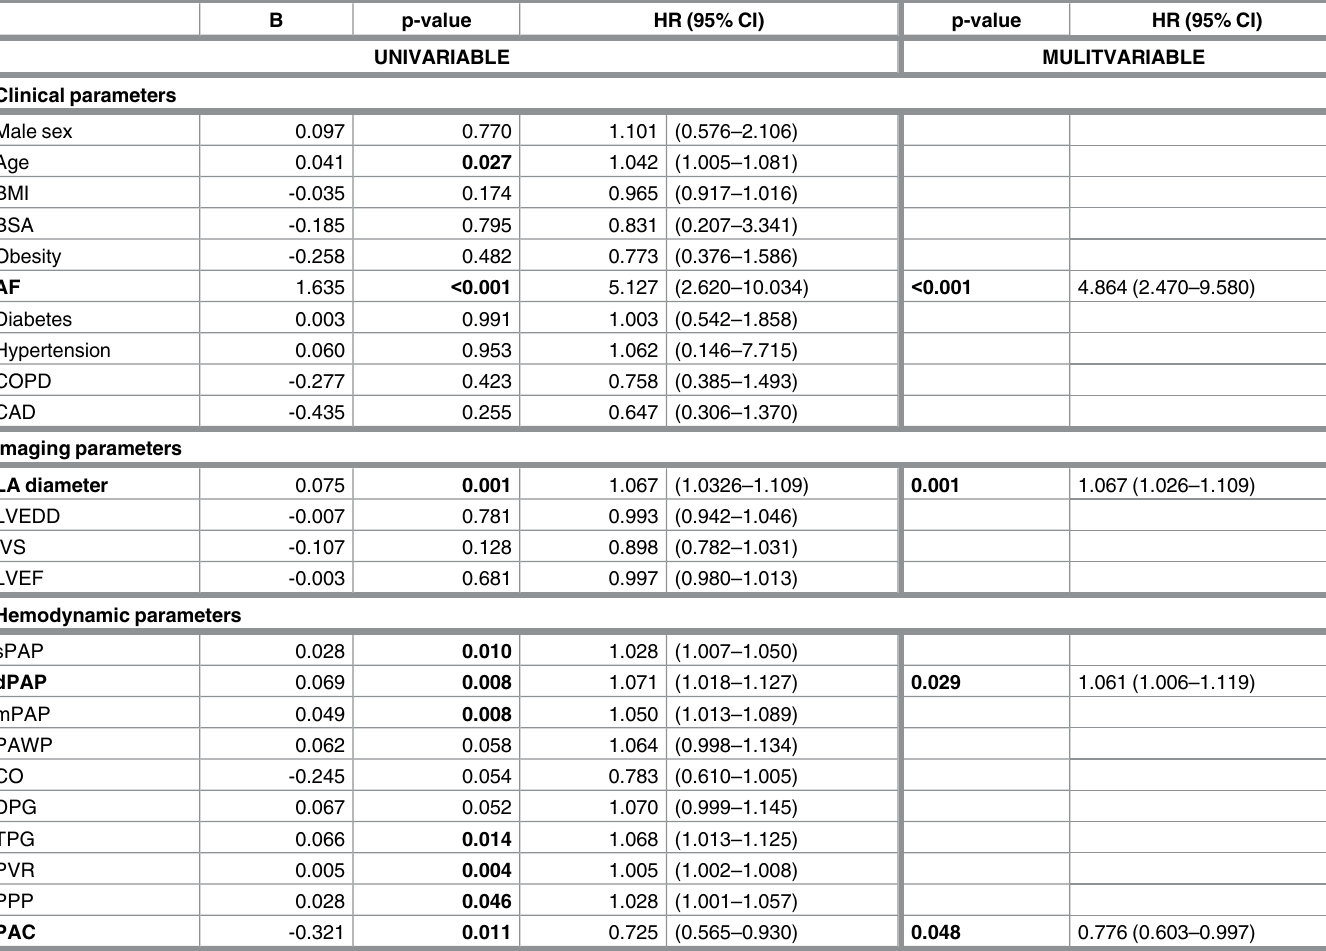
Table 7. Uni- and multivariable binary logistic regression analysis for the presenceof significant tricuspid